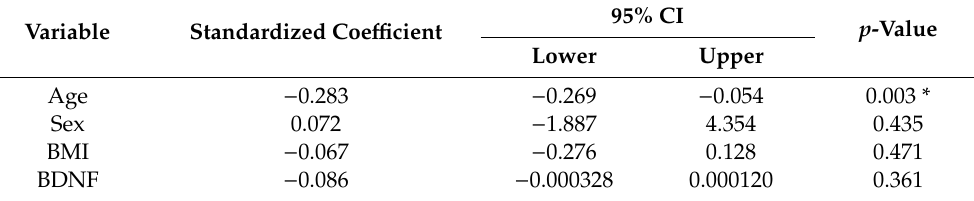
Table 5. Multivariable Linear Regression for High Risk Group ( n = 117).